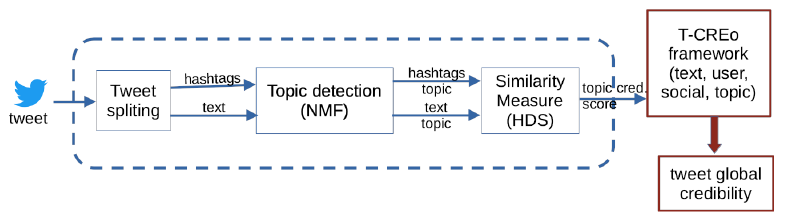
Figure 6. Topic detection